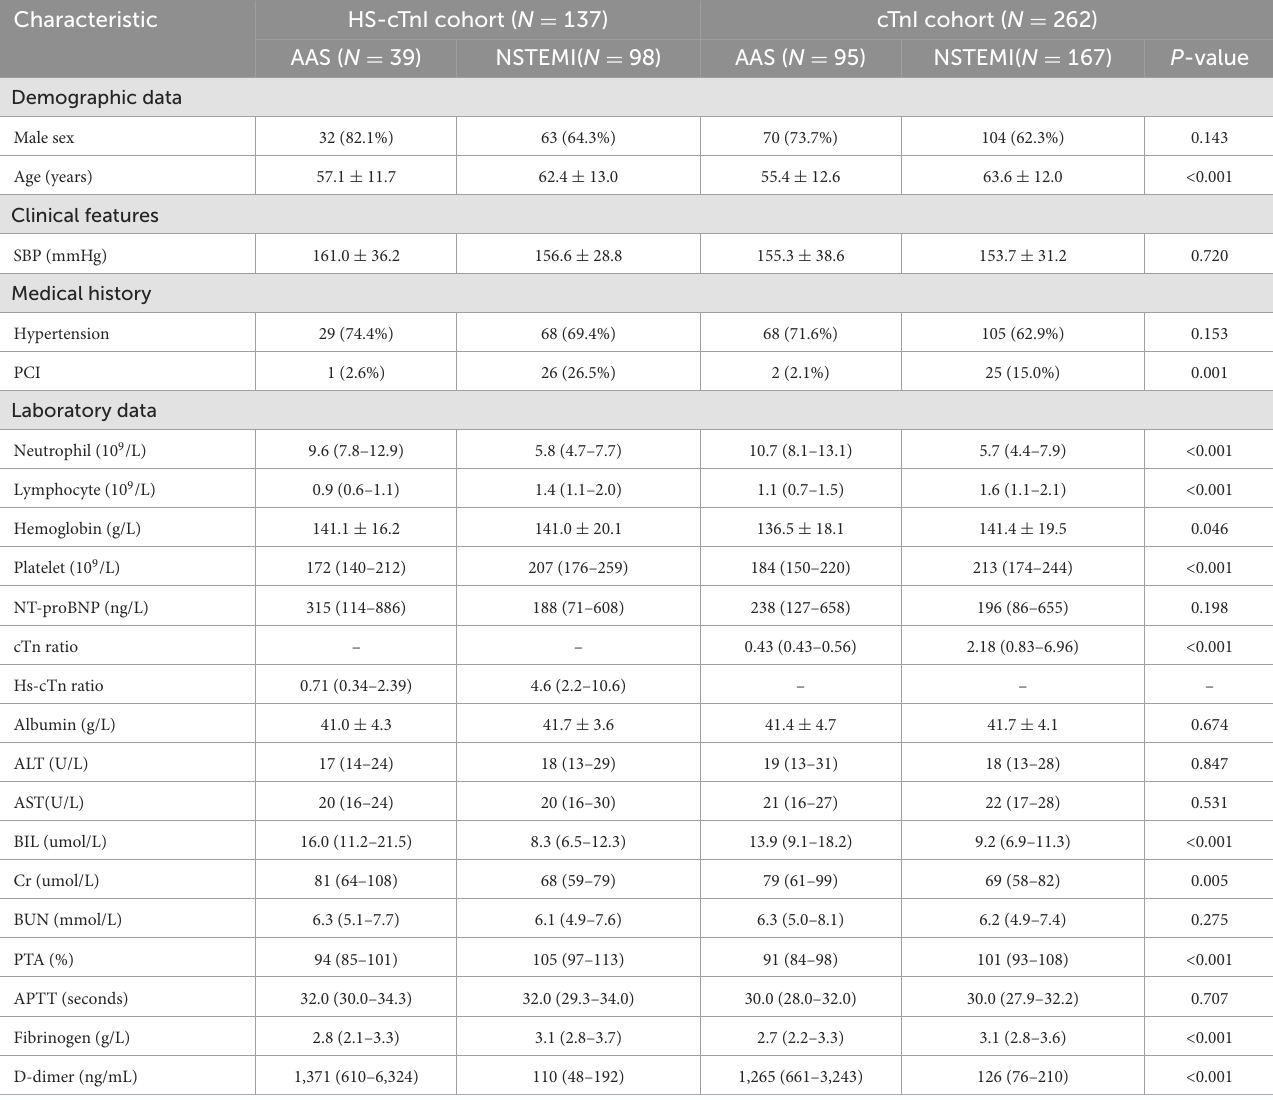
TABLE 4 Baseline characteristics of AAS vs NSTEMI with chest pain onset ≥